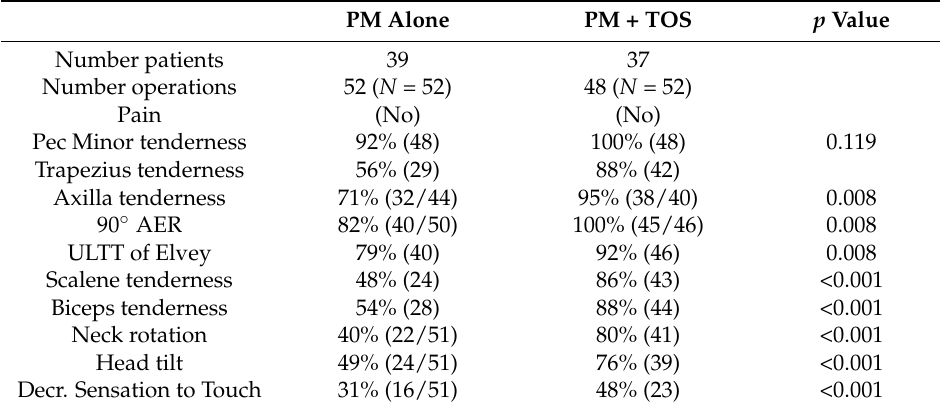
Table 4. Physical exam–incidence of positive